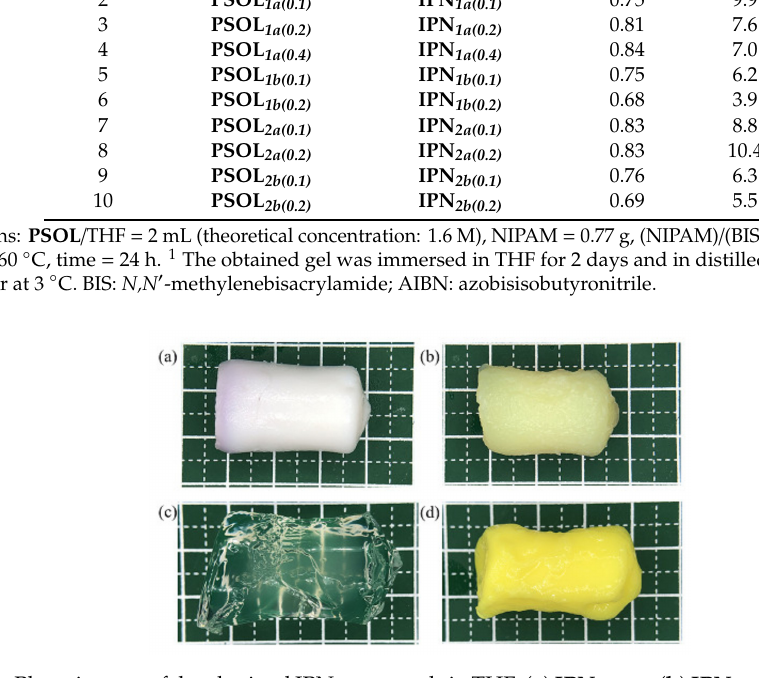
Figure 2. Photo images of the obtained IPN organogels in THF; ( a ) IPN 1a(0.2) , ( b ) IPN 1b(0.2) , ( c ) IPN 2a(0.2) , and ( d ) IPN 2b(0.2)